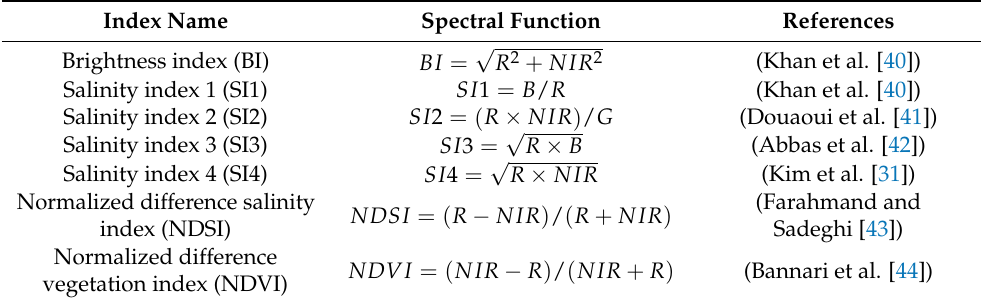
Table 2. Reference salinity indices used in this